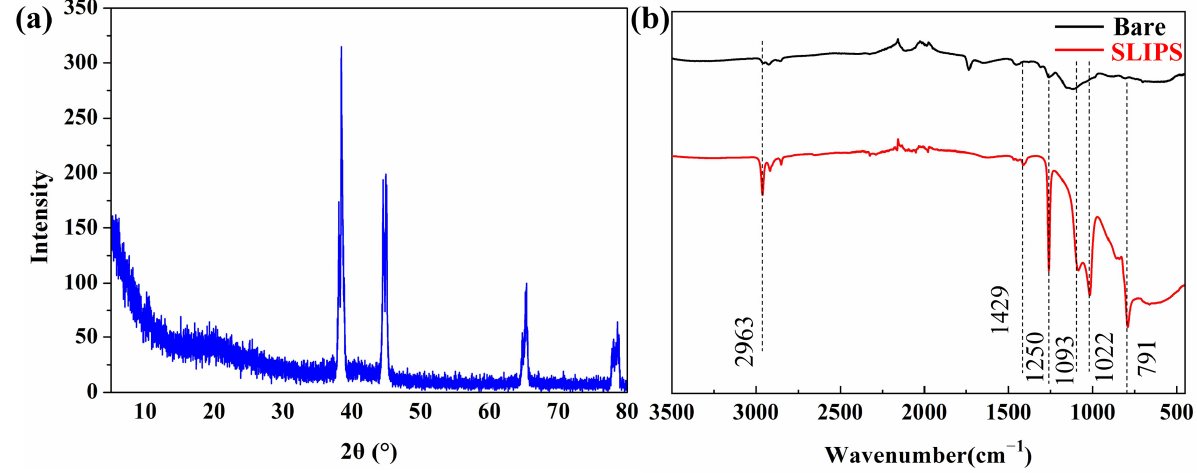
Figure 3. XRD spectrum of porous anodic aluminum oxide (PAAO) ( a ) and the FTIR spectrum of a bare aluminum alloy surface and SLIPS ( b ).